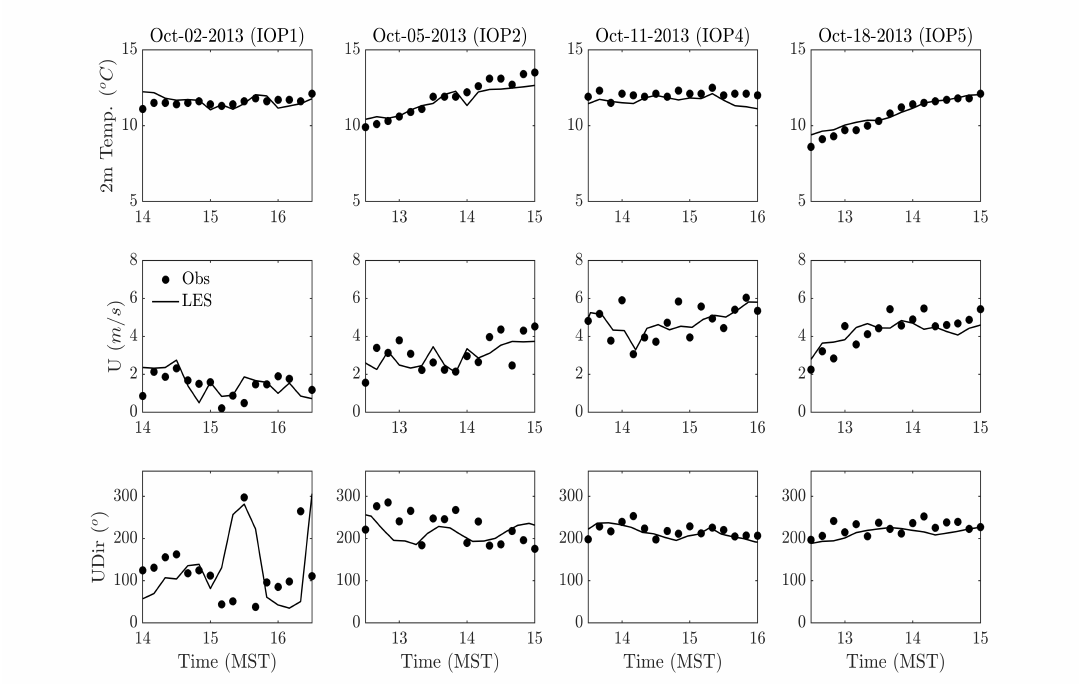
Figure 7. Variation of 2-m temperature (2m Temp, top row ), 10-m wind speed (U, middle row ) and direction (UDir, bottom row ) during 2.5 h of individual IOPs of